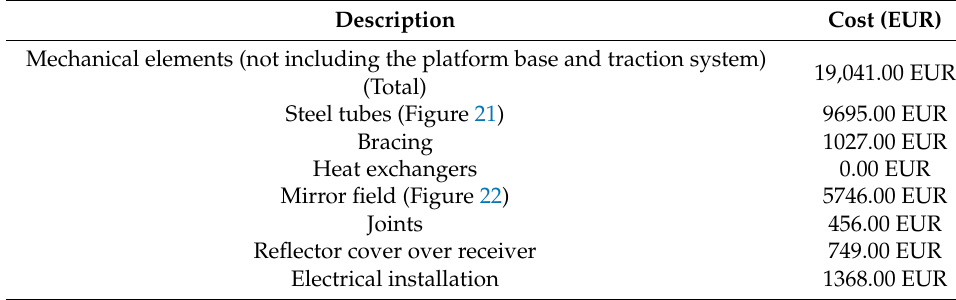
Mechanical elements (not including the platform base and traction system)